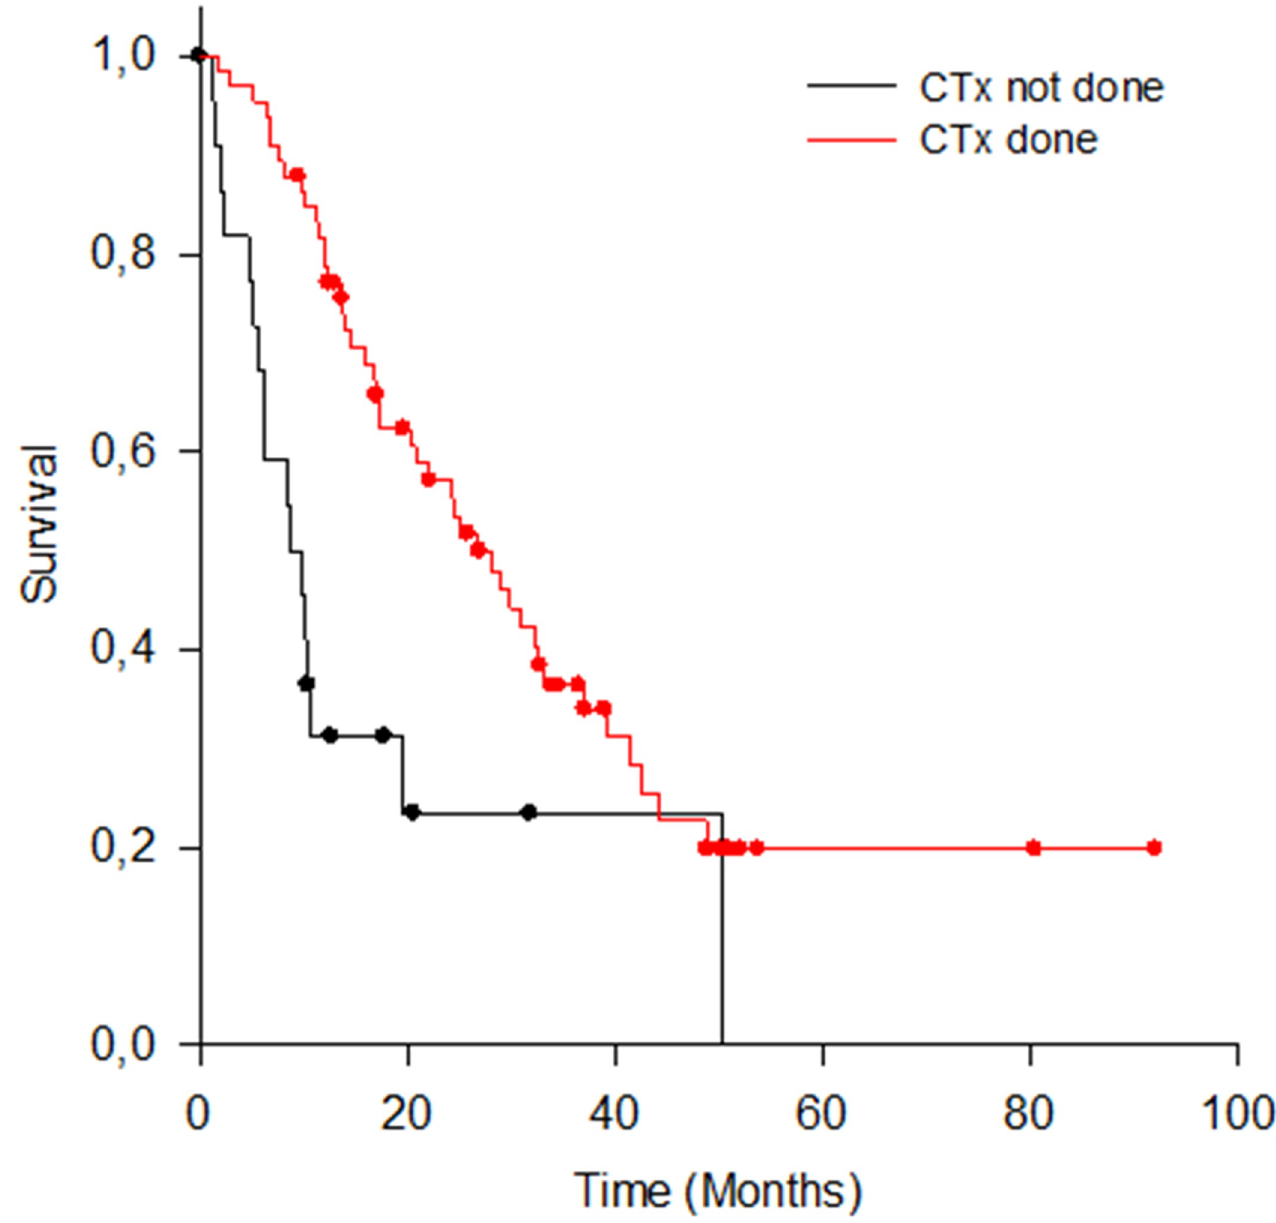
Fig 6. OS for patients with and without